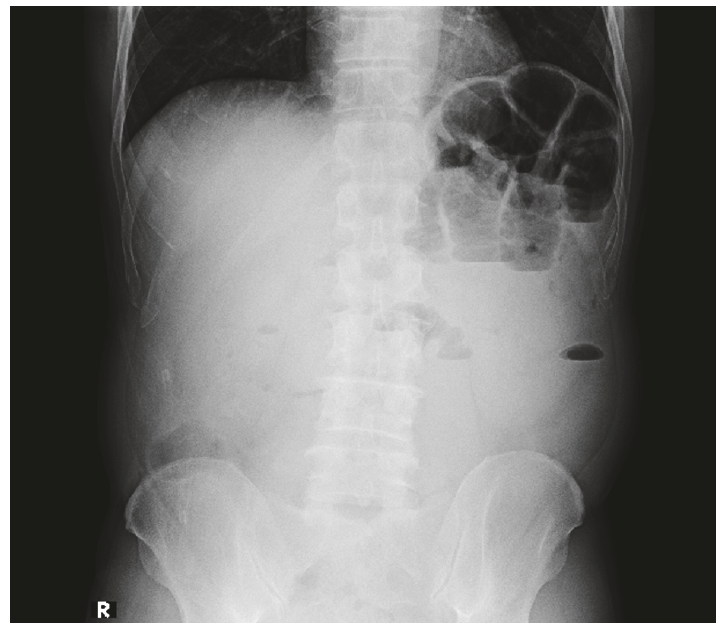
Figure 1: Abdominal radiography performed in upright position revealed distended loops of small bowel containing gas and fluid in the left upper abdomen.